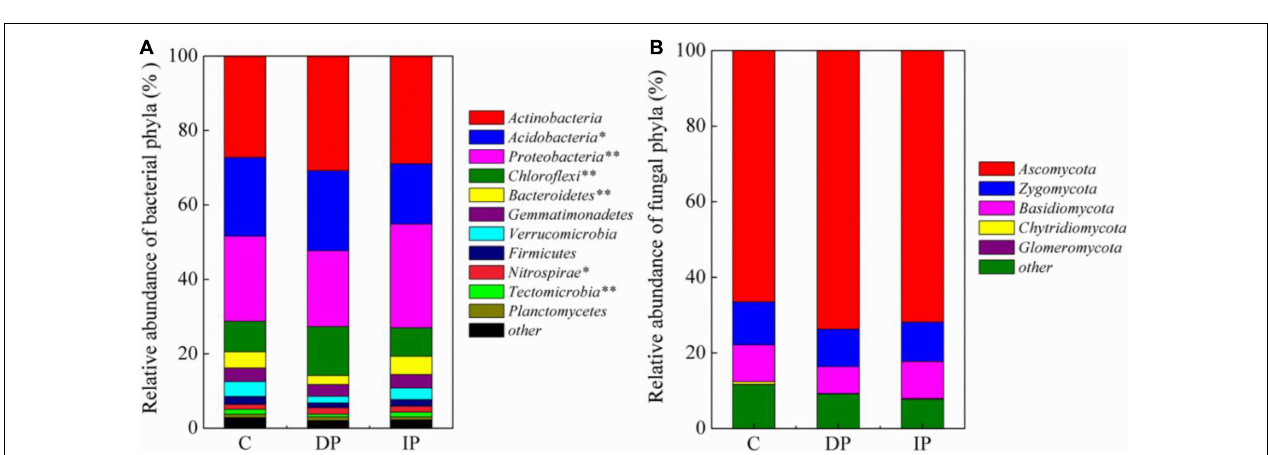
FIGURE 2 | Non-metric multidimensional scaling analysis (NMDS) of soil bacterial and fungal communities under decreasing precipitation (DP) and increasing precipitation (IP). See Figure 1 for abbreviations.